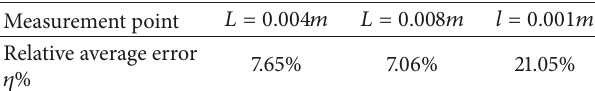
Table 2: Relative average errors of inversion result in different measurement point positions given 𝜎 = 0.001 and 𝑅 = 5